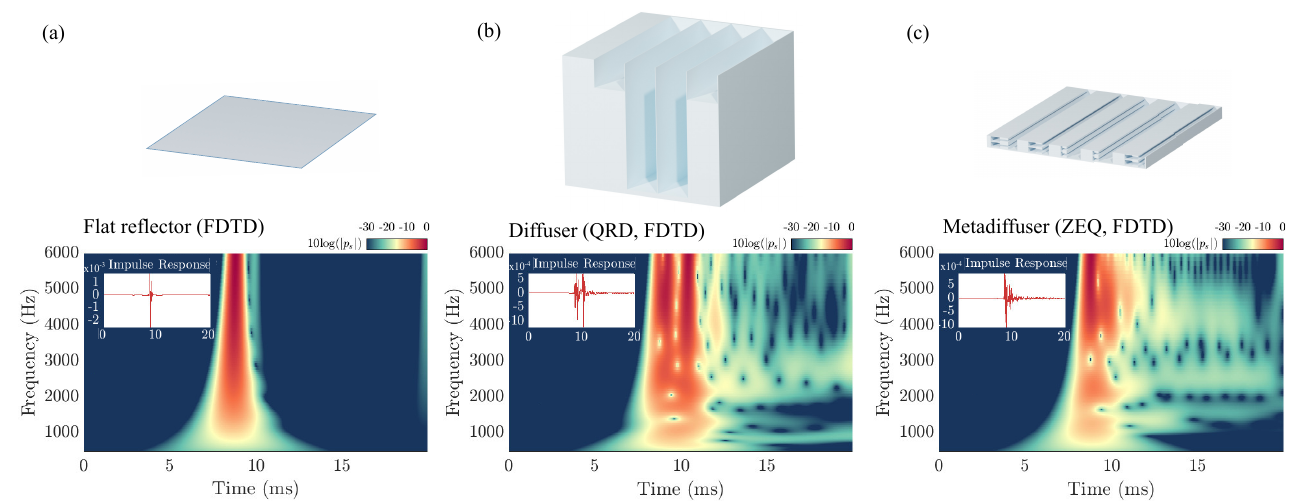
Figure 5. Wavelet transforms of scattered impulse responses corresponding to ( a ) a flat panel via 3D FDTD, ( b ) the QRD via 3D PSTD, and ( c ) the ZEQ via 3D FDTD. Insets represent the reconstructed inverse wavelet transform of the original impulse